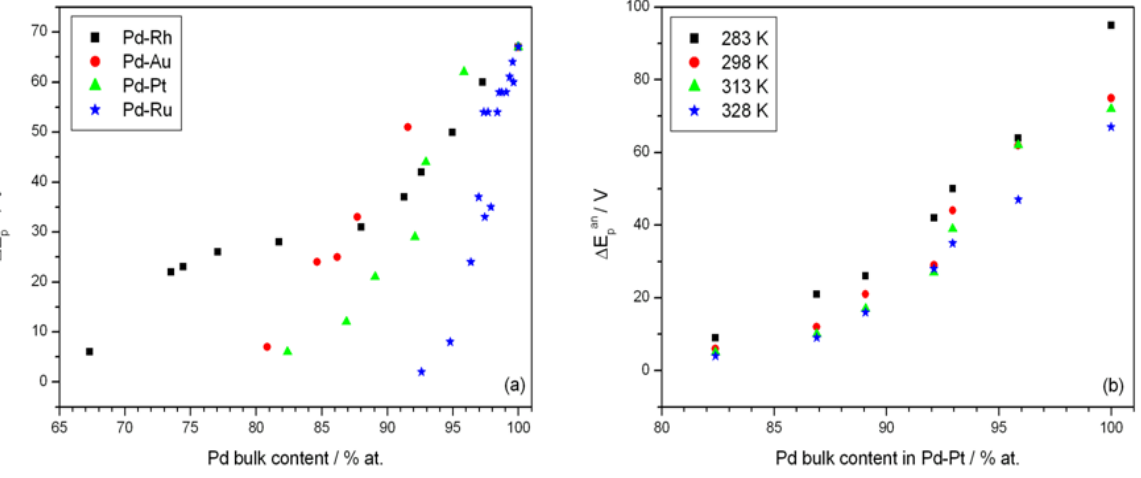
Figure 7. Influence of alloy bulk composition on the difference between minimum value of the potential of anodic peak 2 just before the phase transition and its final value at low electrosorption potentials (ΔE pan ): ( a ) for various alloys at 298 K; ( b ) at various temperatures for Pd-Pt alloys.